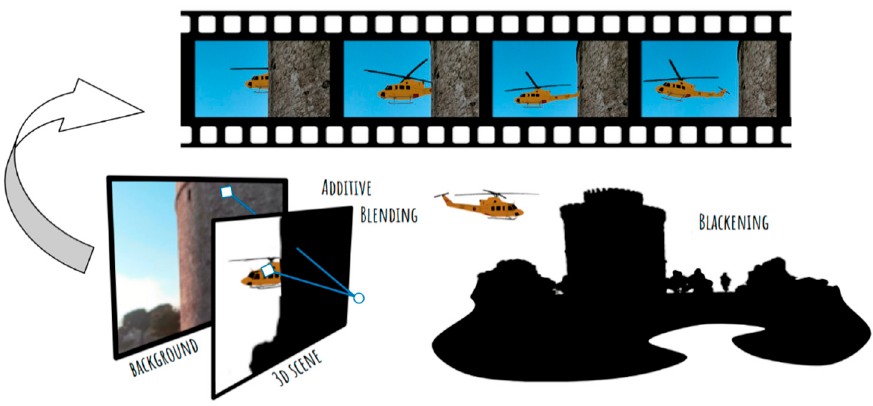
Figure 10. Transforming a 3D mapped object to a 3D invisible object.